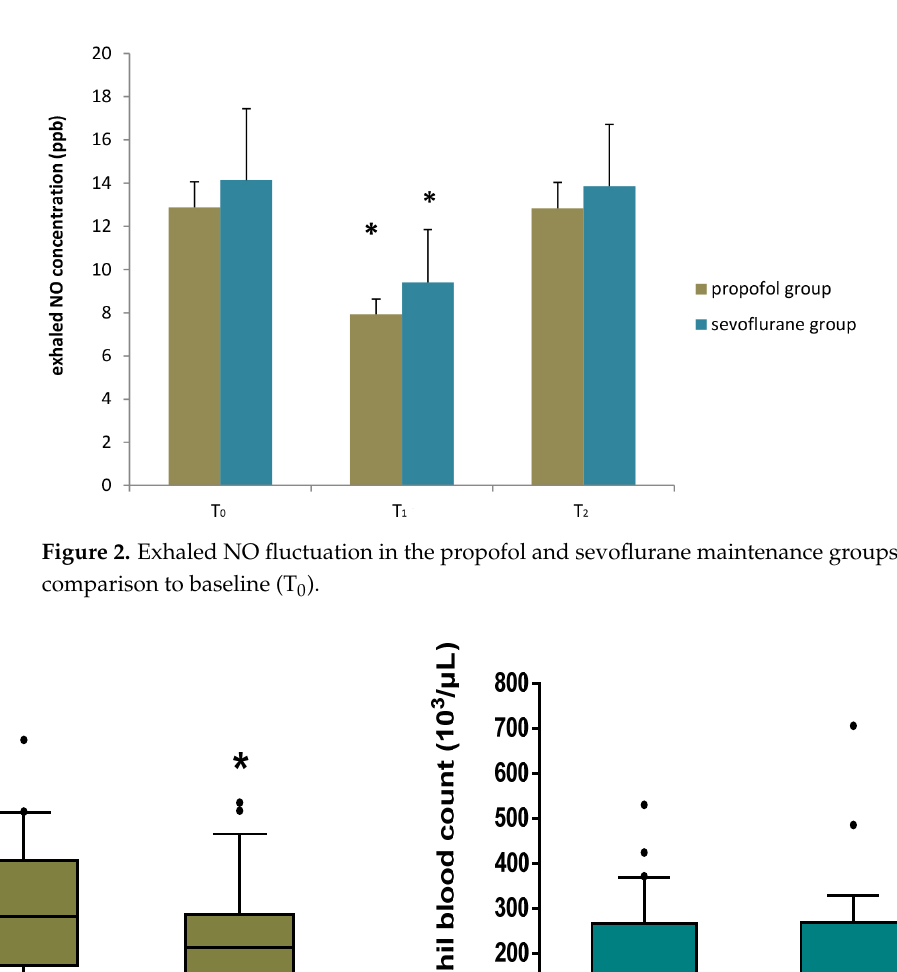
Figure 2. Exhaled NO fluctuation in the propofol and sevoflurane maintenance groups; * p < 0.05 in comparison to baseline (T0).